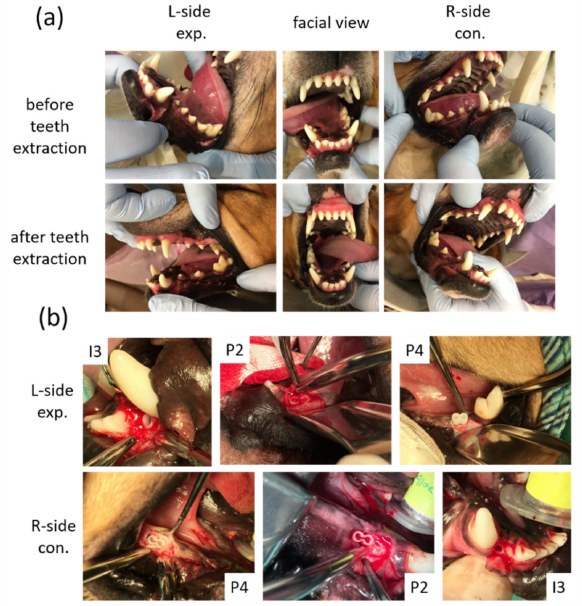
Figure 3. Macroscope observation for tooth regeneration. ( a ) The incisor and the premolar teeth in the right and left mandibular jaw quadrants before and after teeth extraction. ( b ) After implantation of 3D-printed HA/PLA scaffolds. L-side: left side; R-side: right side; I3: the third incisor; P2: the second premolar; P4: the fourth premolar.